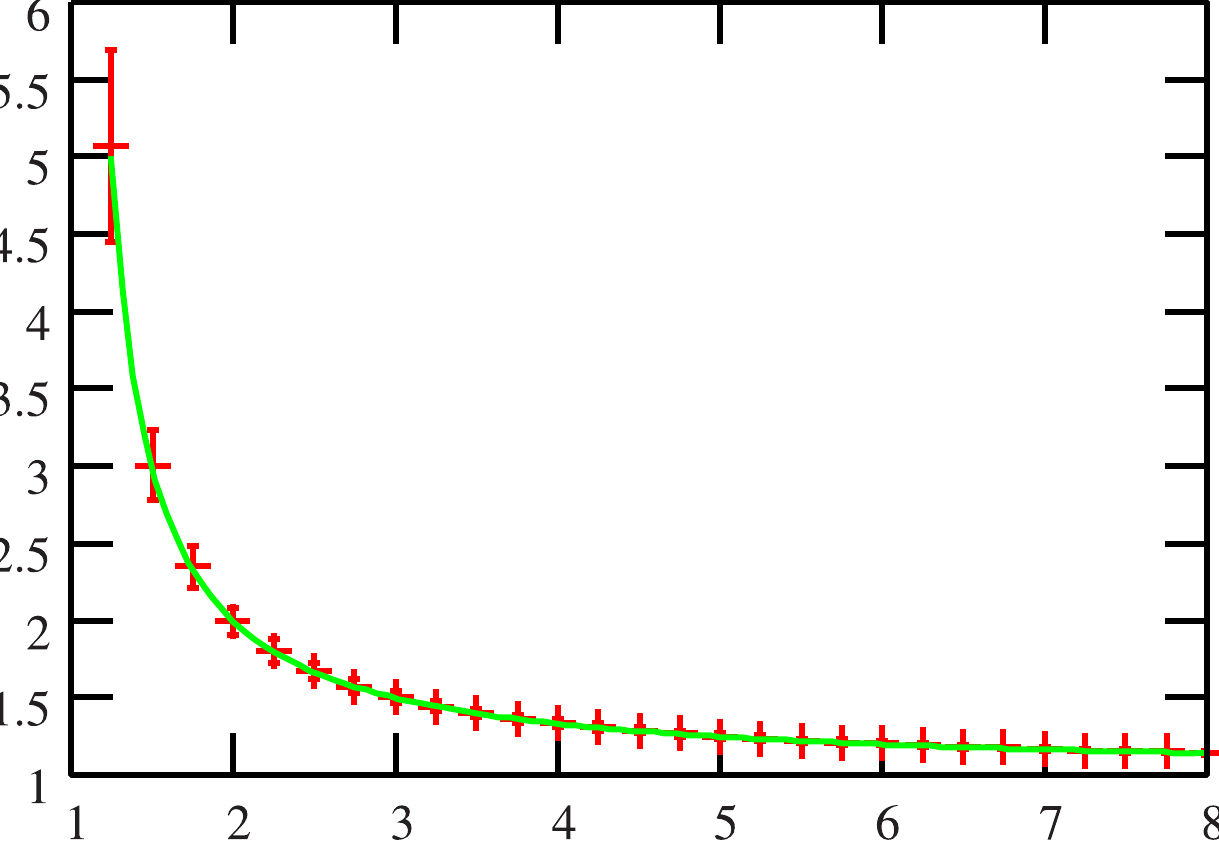
Fig 1. The reference ratio α = p / N (horizontal axis) versus the quenched overlap parameter q (vertical axis). The numerical experimental results from the proposed algorithm (error bars) are assessed from 10 2 experiments using N = 500 assets. Comparing with the results of replica analysis (solid line), the effectiveness of proposed algorithm is